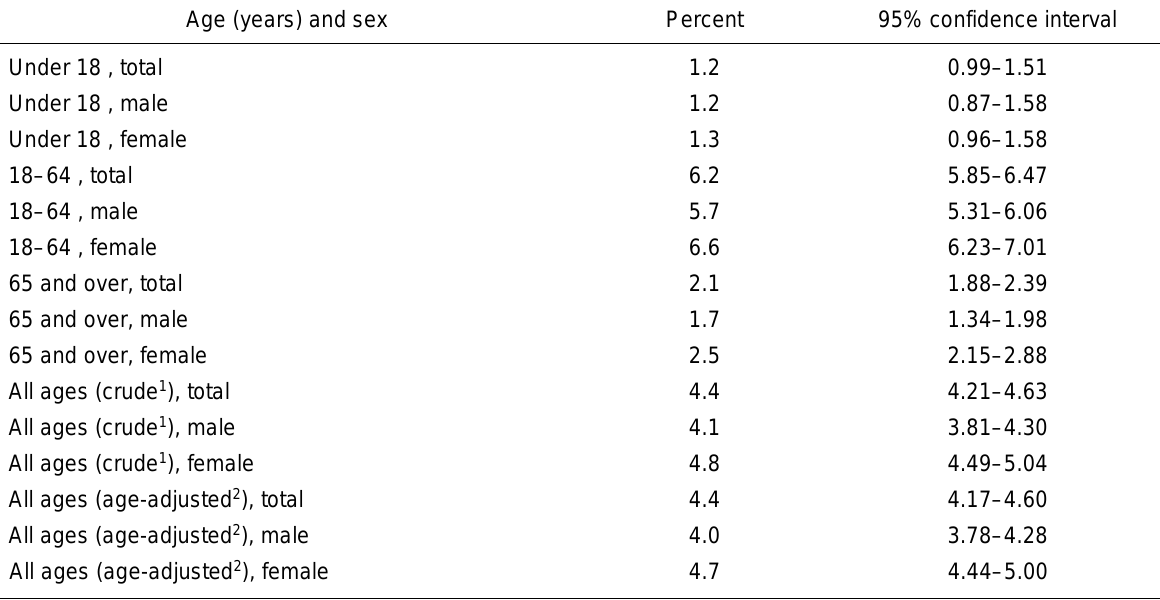
Data table for Figure 3.2. Percentage of persons of all ages who failed to